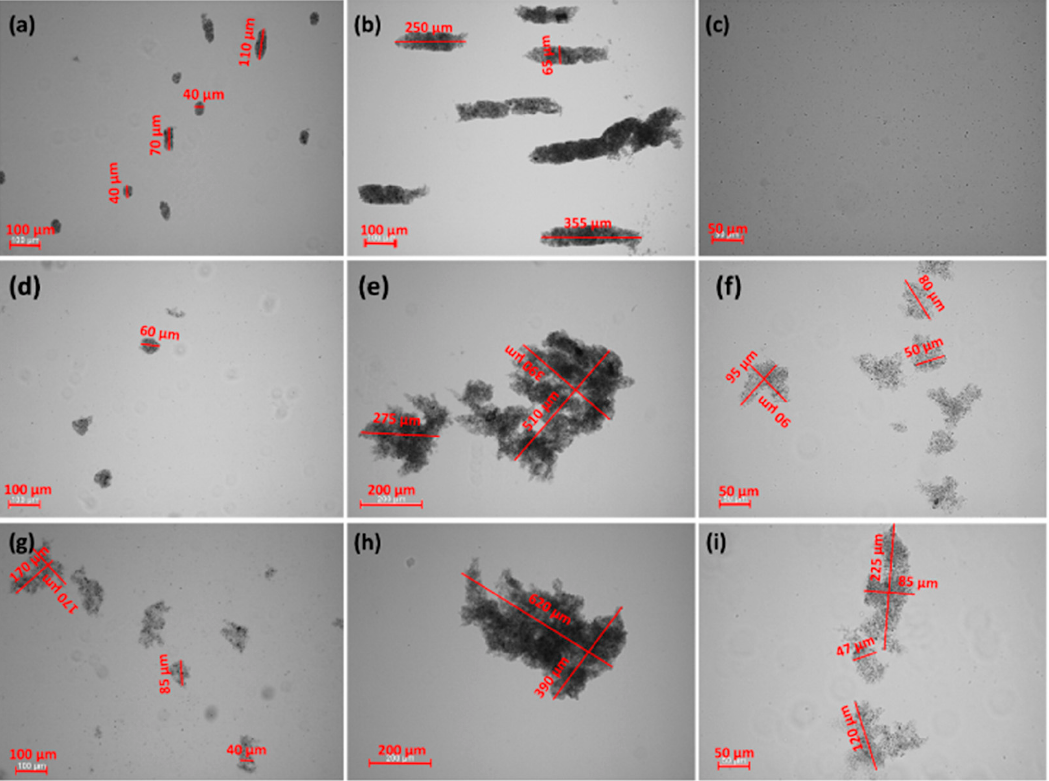
Figure 4 . Optical microscope images of the GT flocs formed with varying CGG concentrations and pH values. IS 0.01 (NaCl): ( a ) 2 ppm of CGG, pH = 3; ( b ) 20 ppm of CGG, pH = 3; ( c ) 20 ppm of CGG, 0.04% CAPB, pH = 3; ( d ) 2 ppm of CGG, pH = 6; ( e ) 20 ppm of CGG, pH = 6; ( f ) 20 ppm of CGG, 0.04% CAPB, pH = 6; ( g ) 2 ppm of CGG, pH = 9; ( h ) 20 ppm of CGG, pH = 9; ( i ) 20 ppm of CGG, 0.04% CAPB, pH = 9.